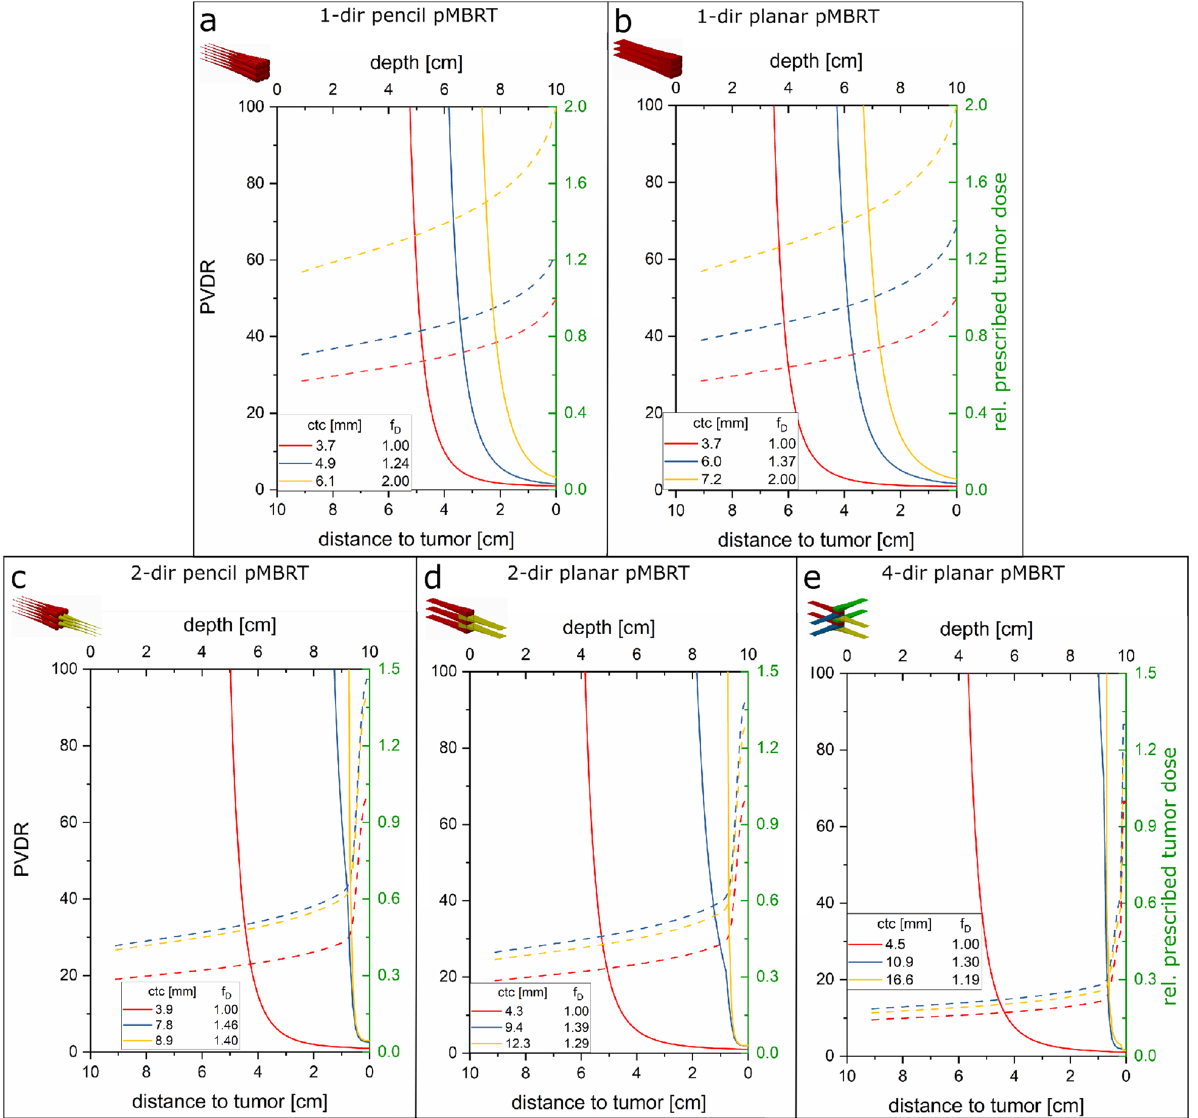
Figure 4. PVDR (full lines, left y-axis) and mean dose (dashed lines, right y-axis) for the heterogeneous (blue and yellow) vs. homogeneous (red) irradiation with planar ( a ) or pencil ( b ) unidirectional, two opposite (2-dir, c and d ), and four-directional (4-dir, e ) minibeams. The mean dose varies due to the dose modulation differences to fulfill the minimum dose constraint within the tumor. The required f D for different ctcs’ are plotted in Fig. 6 as an example for 2-dir planar